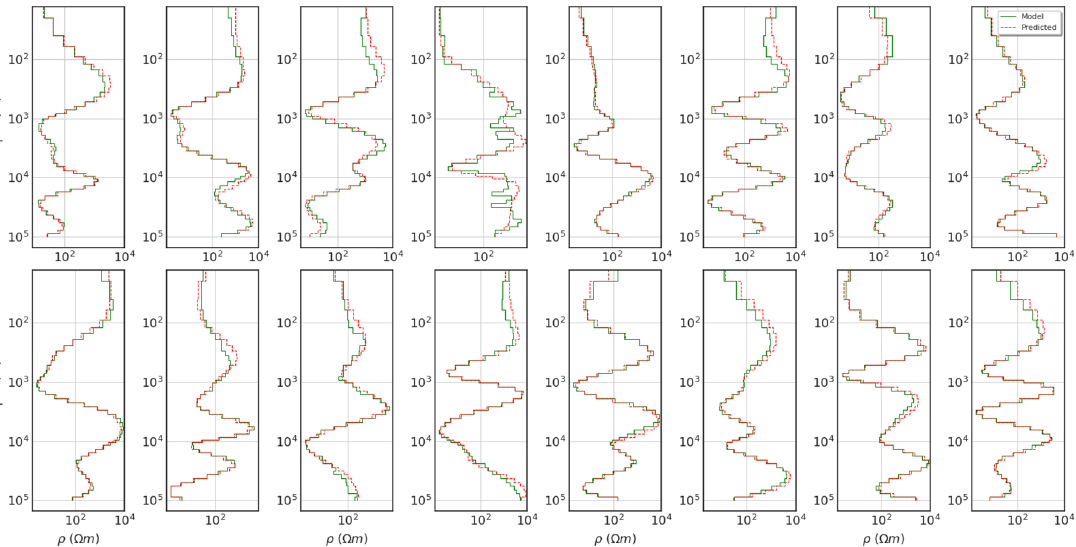
Figure 4. Comparison of calculated resistivity with testing datasets in Figure 3(a) (green solid line is the true model; red dashed line is the predicted resistivity with a trained CNN model).